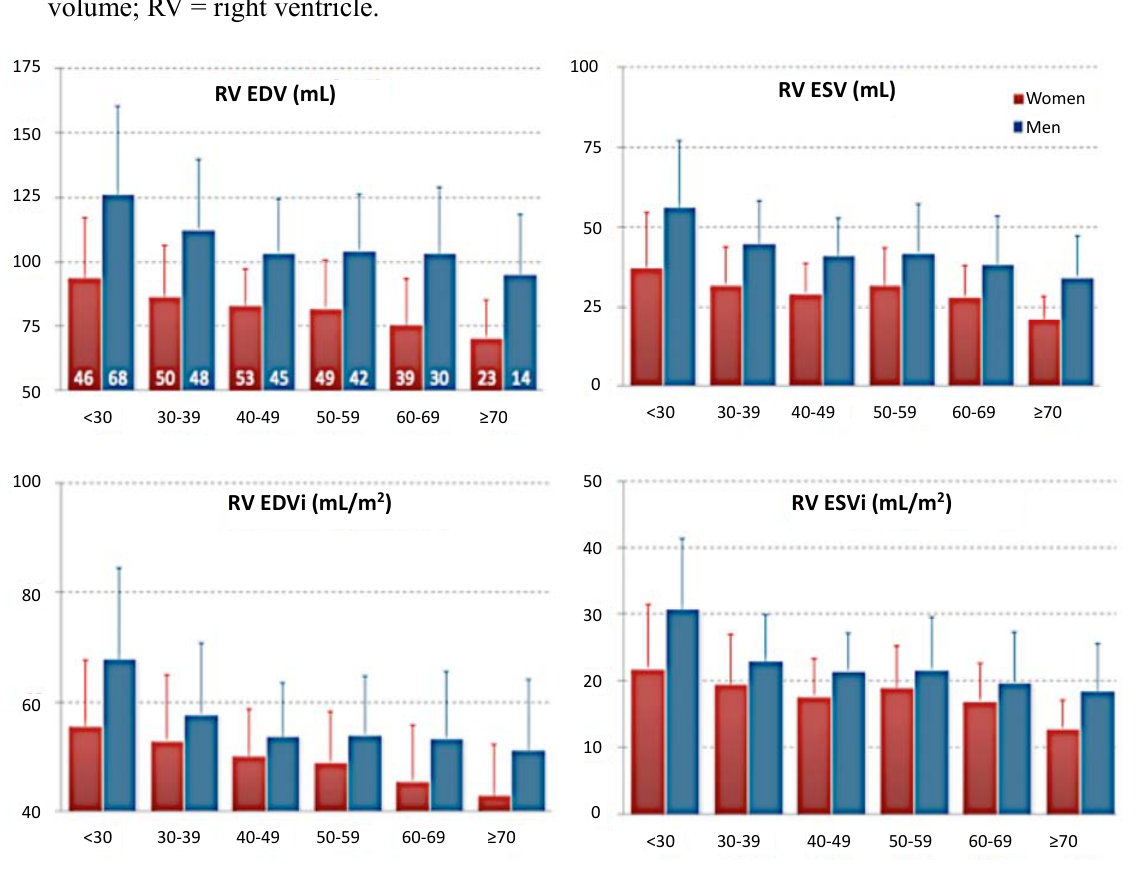
Figure 4. Right ventricular volumes varies with gender and age, unrespect to body size. (Modified from Maffesanti et al. [58]). EDV = end-diastolic volume; ESV = end-systolic volume; RV = right